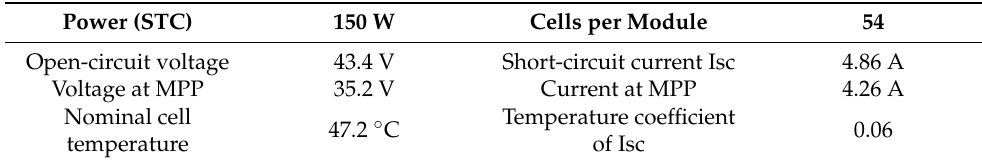
Figure 1. Process flow of the experimental setup. Table 3. PV array block parameters (Ningbo solar electric power